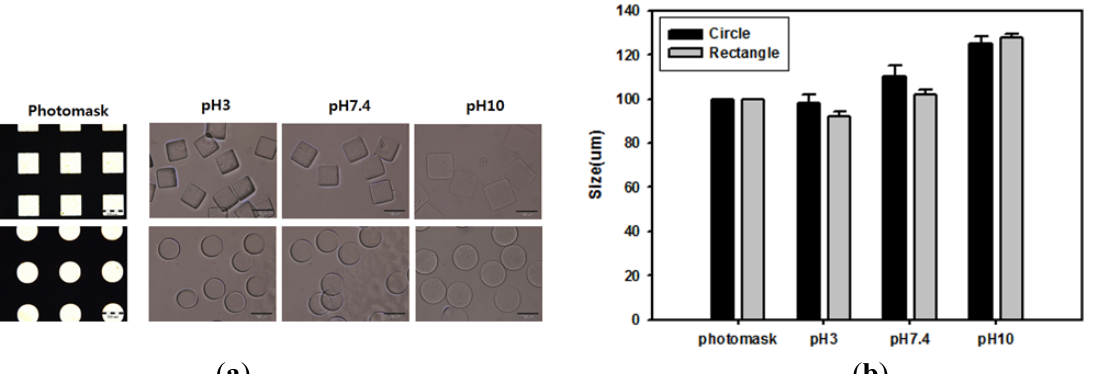
Figure 3. Effect of pH on the morphology of hydrogel microparticles. ( a ) Optical images of hydrogel microparticles that were immersed in different pH buffer solution for 2 h (scale bar: 100 μ m). ( b ) Actual lateral dimensions of hydrogel microparticles in different pH buffer